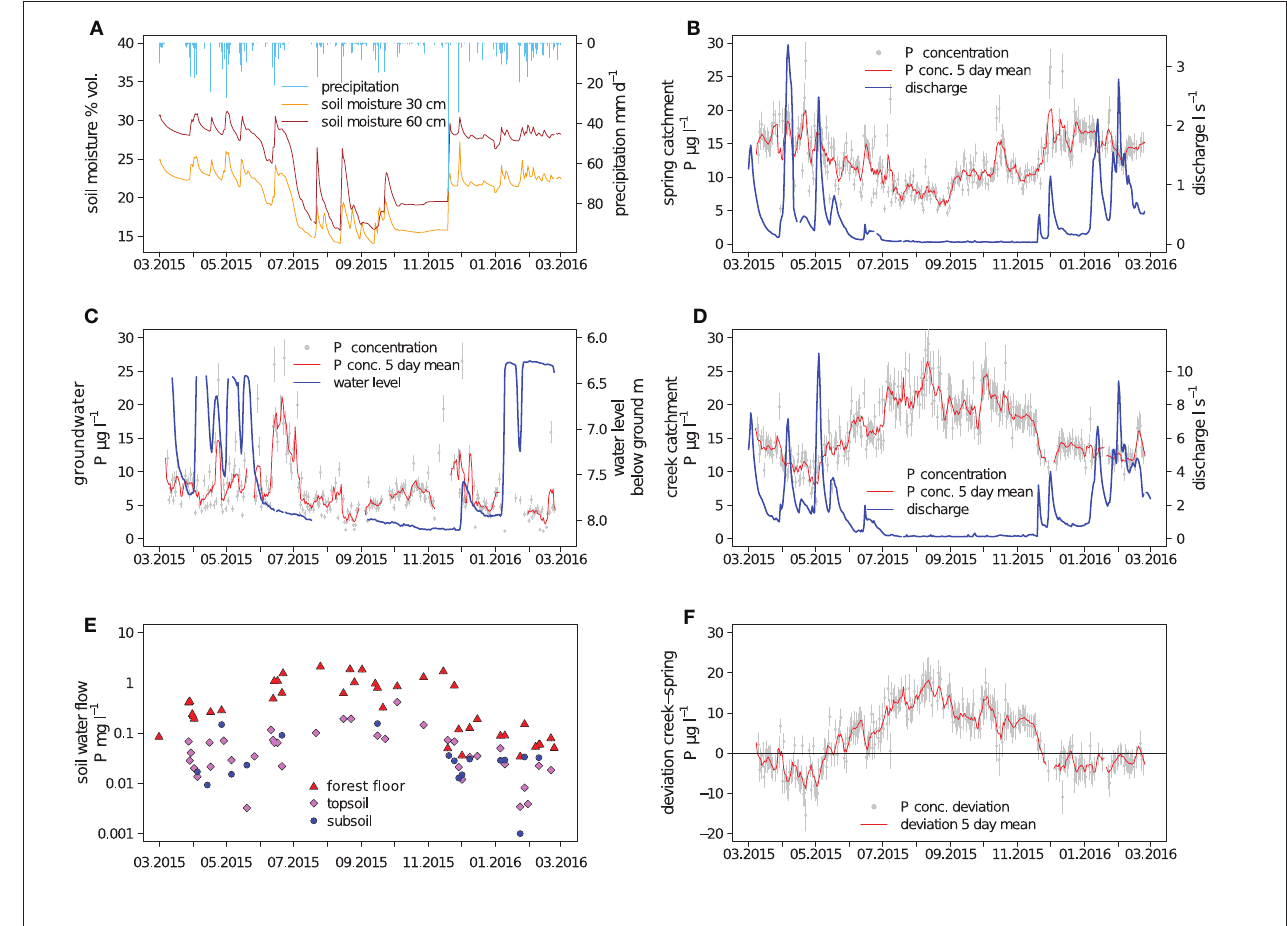
FIGURE 1 | Hydrological variables and phosphorus (P) concentrations; bulk precipitation and soil moisture (A) . Discharge and dissolved P concentrations in the spring and creek catchment (B,D) ; water level and P concentrations in the groundwater (C) . P concentrations of lateral subsurface flow (E) ; deviation of P concentration in discharge between the creek and spring catchment (F) ; depth intervals of subsurface flow were 0–15cm (forest floor), 15–150cm (upper mineral soil), and 150–320cm (deeper mineral soil); uncertainty bars represent the standard deviation of the arithmetic mean.